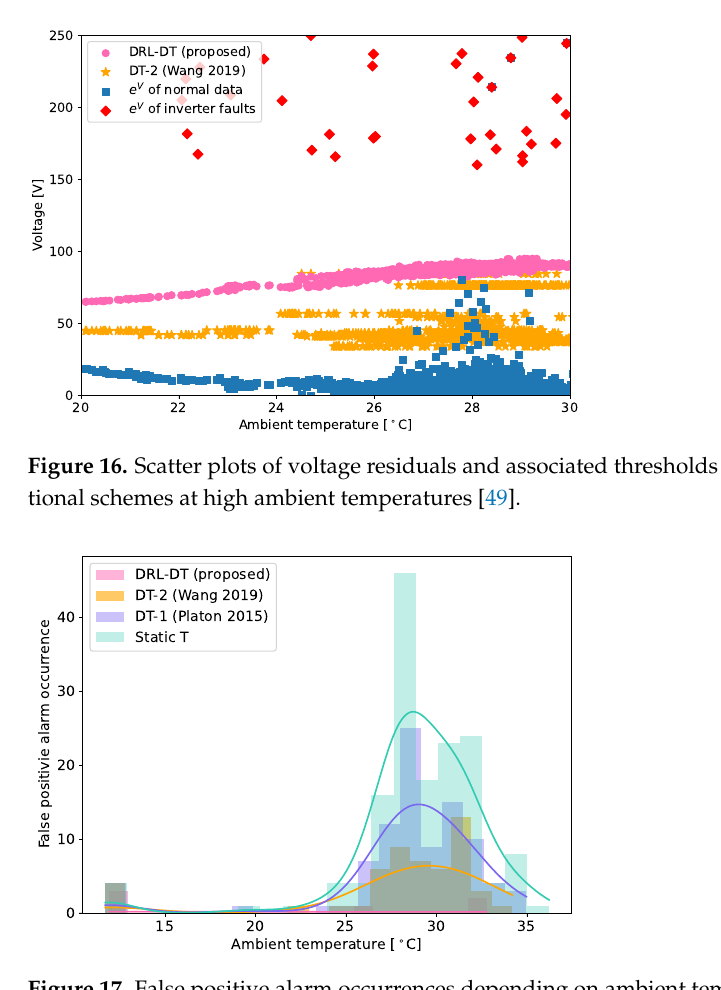
Figure 15. Power residuals and dynamic threshold profiles in a test day recorded at high ambient tem- peratures [49].